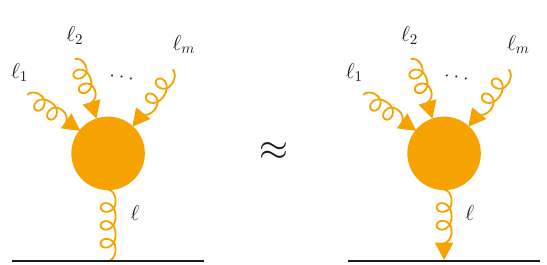
Figure 7 . Graphical representation of the approximation (4.6). The line at the bottom can be either a right-collinear parton or an eikonal line along v A . Here and in the following, an arrow on a gluon line represents the insertion of a Grammer-Yennie factor (2.6), with the arrow on the side of the momentum vector. Round blobs denote the tree-level vertices V ( m ) speci(cid:12)ed in the